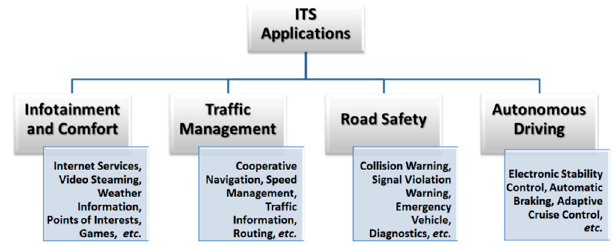
Figure 1. Intelligent transport system (ITS) application classification, source [14].